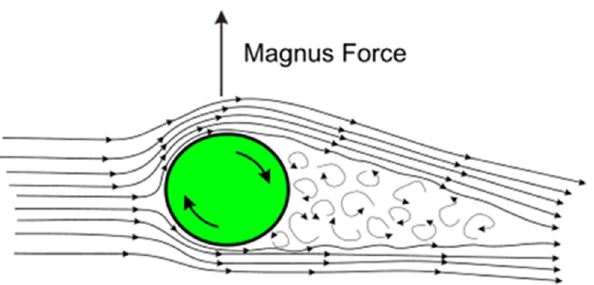
Figure 5. Fluid interaction with a rotor.